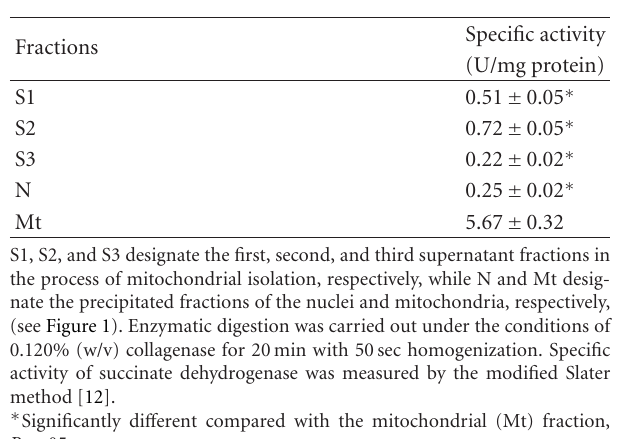
Figure 2: A polarographic trace of gingival mitochondria (Mt). Mt were prepared from approximately 1.0 g rat gingival tissue using an optimized preparative procedure displaying apparent respira- tory activity. The preparation conditions are 50sec of polytron homogenizer treatment and 0.120% (w/v) collagenase. Oxygen consumption by the gingival Mt (0.5mg protein/ 600 µ L bu ff er) was measured with the addition of substrate (0.6mM succinate) followed by 30 µ M adenosine diphosphate (ADP) at 25 ◦ C. Table 1: Specific activity of succinate dehydrogenase (SDH) in the various fractions in the process of mitochondrial isolation.